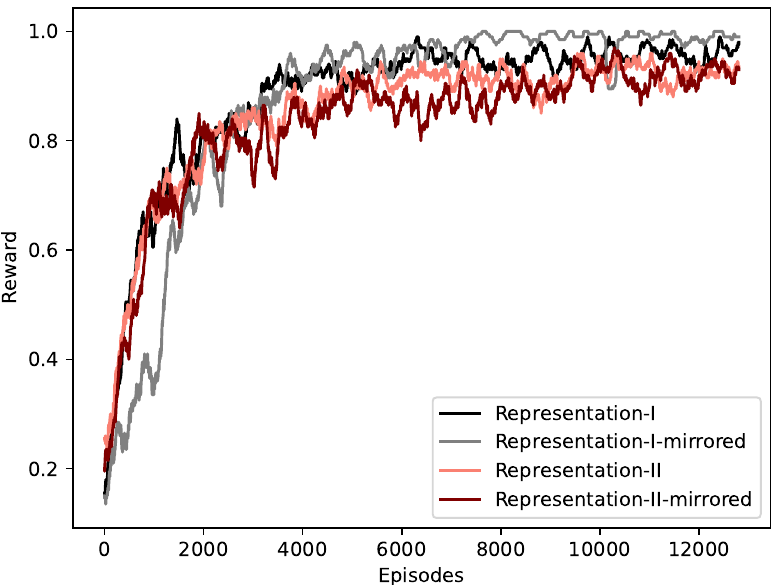
Figure 5. Convergence of the MADRL agent during the training of either the mirrored or the original